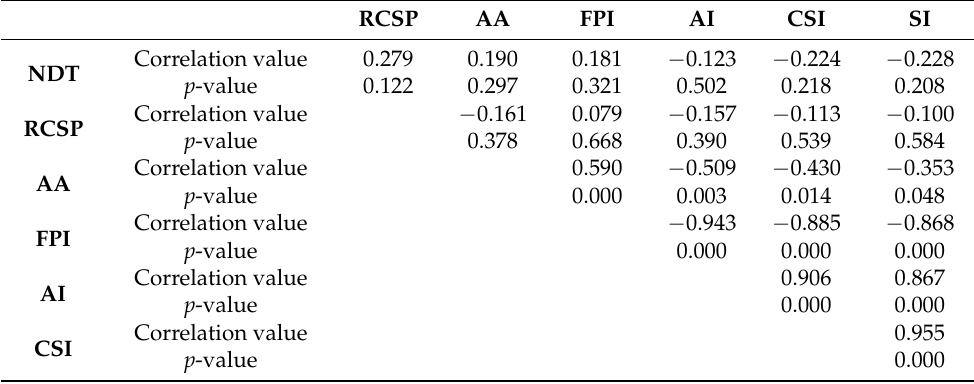
Table 4. Pearson’s correlation values of the flatfoot group between all